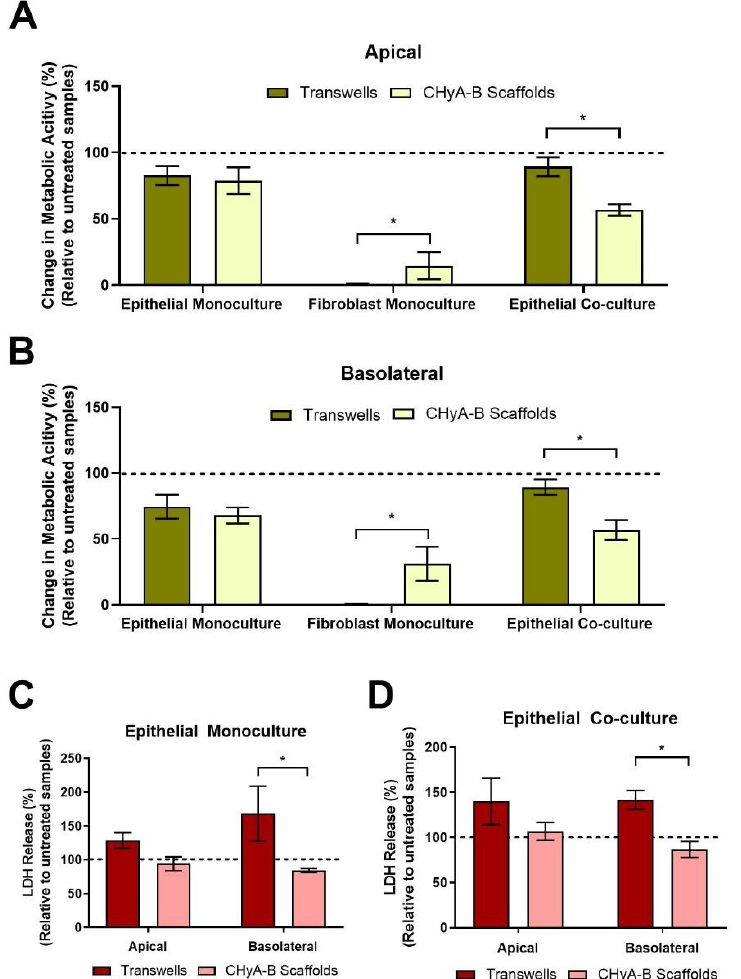
Figure 4. Cell viability on Transwell ® inserts and CHyA-B scaffolds following drug-mediated challenge. Apical ( A ) and basolateral ( B ) cell metabolic activity of Calu-3 epithelial monocultures, Wi38 fibroblast monocultures, and Calu-3 Wi38 epithelial co-cultures on Transwell ® inserts and CHyA-B scaffolds following exposure to 100 µ g/mL of bleomycin for 24 h and measured at day 23 in culture. Apical and basolateral LDH release from Calu-3 epithelial monocultures ( C ) and Calu-3 Wi38 epithelial co-cultures ( D ) on Transwell ® Inserts and CHyA-B scaffolds following bleomycin exposure. Changes in metabolic activity and LDH release are relative to untreated samples for each culture condition. Results displayed as mean ± SEM ( n ≥ 3; * p < 0.05).